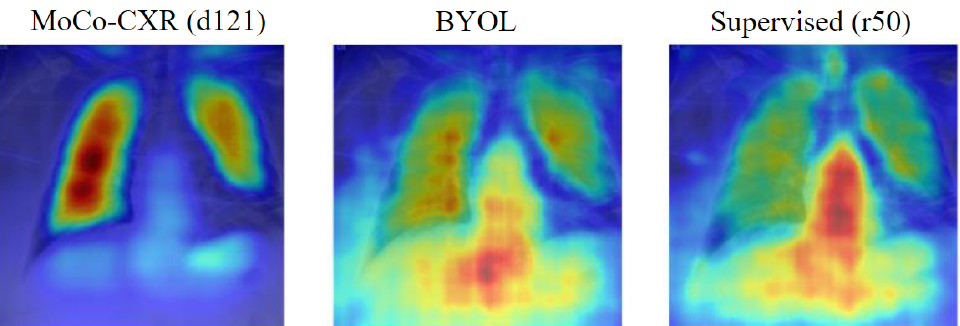
Figure 8. Saliency map for an image from the CheXpert dataset for the MoCo-CXR ( left ), BYOL ( centre ) and Supervised ResNet-50 ( right ) models. The three saliency maps have attentive diffusion values 0.33 (MoCo-CXR), 0.50 (BYOL), and 0.47 (Supervised